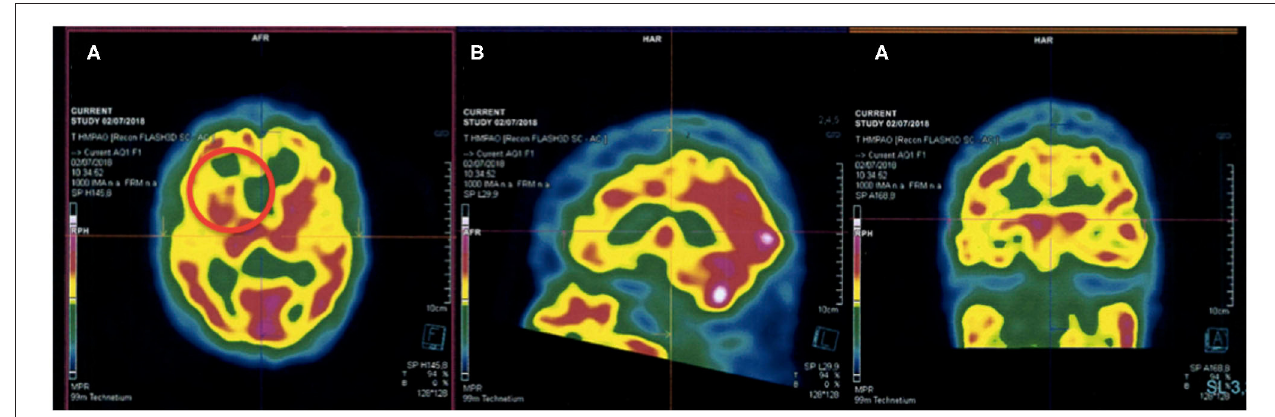
FIGURE 1 | Brain perfusion SPECT showing (A) hypometabolism of the right dorsal striatum (red circle), (B) hypometabolism of the frontal lobes, and (C) hypometabolism of parieto-occipital